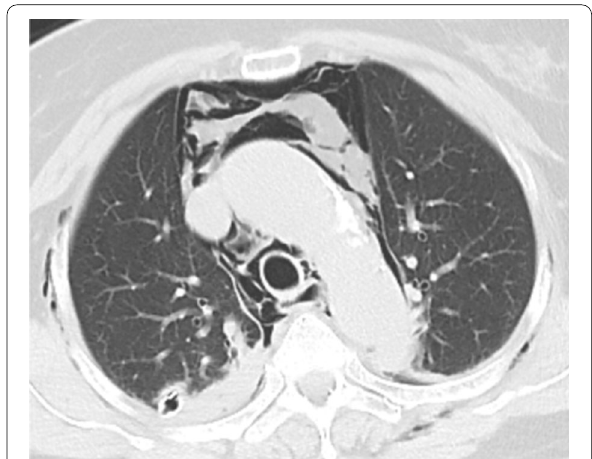
Fig. 3 Postoperative CT revealed mediastinal and subcutaneous emphysema without any evident tracheal